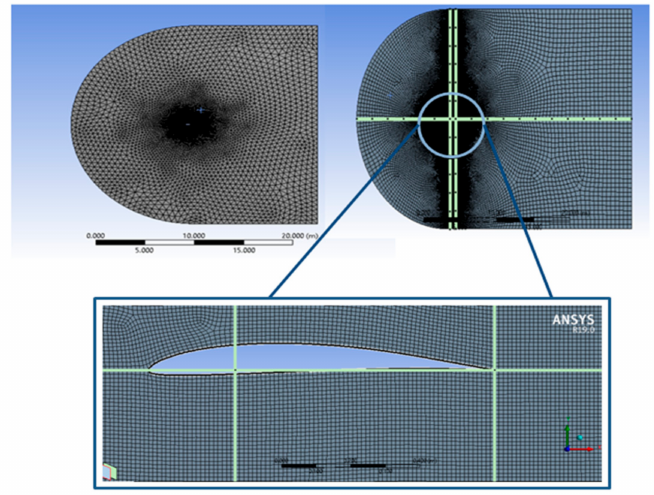
Figure 6. Mesh generated in the fluid medium for DAE 51 aerofoil. After meshing, the boundary conditions are defined where the incoming edge of the mesh is defined as the velocity inlet, and the rear end is the pressure outlet. Corresponding solutions are determined for every design point by varying the effective angle of attack in each iteration from − 10 ◦ to 110 ◦ where the mesh motion is set to 0.5 rad/s. The solution plot signifying the variation of C L and C D with changes in the attack angle is shown in Figure 7.